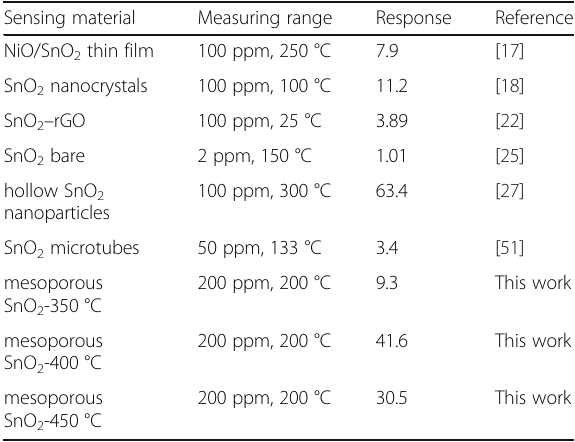
Table 2 Sensing performances of mesoporous SnO 2 to ethanol in this work and previously reported sensing